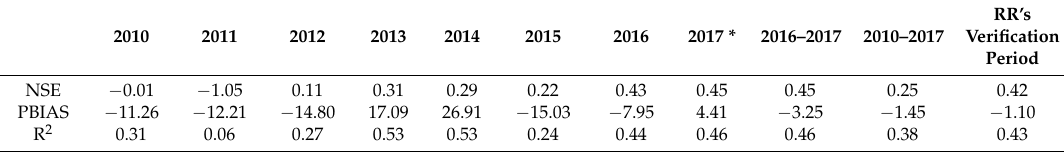
Table 11. HSPF model